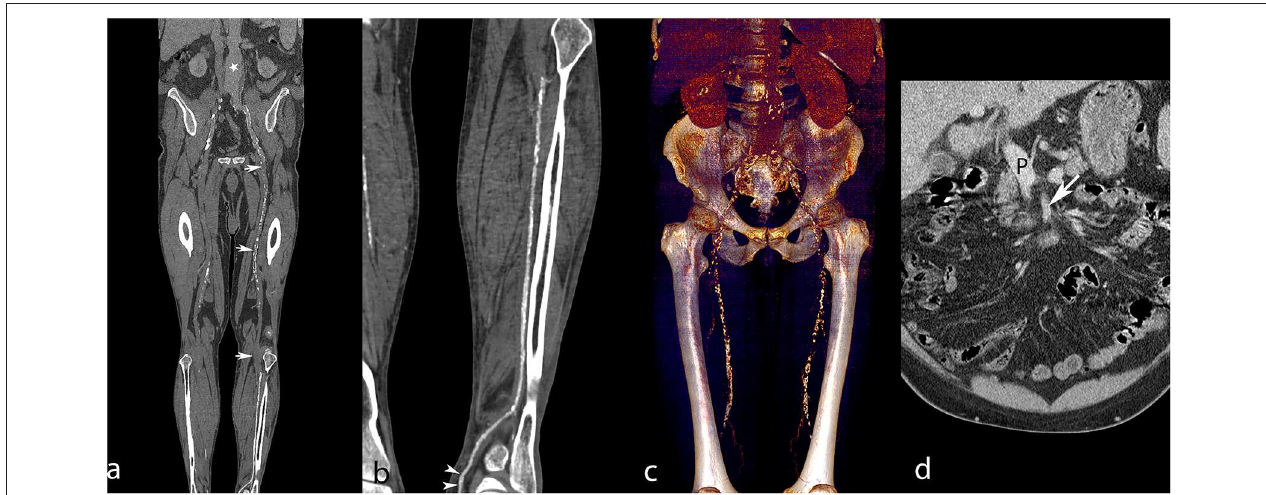
FIGURE 6 | Lower extremity CT angiography obtained with the RA technique in a 65-year-old man with a history of ischemic and hypertensive heart disease, atrial fibrillation, chronic obstructive pulmonary obstruction, past stroke, and an aneurysm of the abdominal aorta. The patient was admitted for critical ischemia of the lower limbs, characterized by Fontaine stage IV disease of the left lower limb with superficial ulceration. Curvilinear reconstruction of the left aortopedal arterial system (a) shows inadequate enhancement of the abdominal aorta (white star) and absent enhancement of the superficial femoral artery due to an extended occlusion (white arrows). Curvilinear reconstruction of the left posterior tibial artery (b) shows optimal enhancement till the pedal level (white arrowheads). Volume rendering reconstruction of the abdominal aorta and femoral arteries (c) provides limited visualization of the arterial system and shows enhancement of the liver and kidneys related to venous contamination. Coronally reformatted slice through the abdomen (d) shows enhanced portal vein (P) and insufficiently enhanced superior mesenteric artery (white arrow), meaning that the sampling instant was too late for arterial phase imaging. Attenuation measurements were as follows: aortic level, 99 HU; iliac level, 85 HU (right) and 94 HU (left); femoral level, 123 HU (right), and 168 HU (left); tibial level 270 HU (right), and 305 HU (left); pedal level, 235 HU (right), and 273 (left). HU, Hounsfield